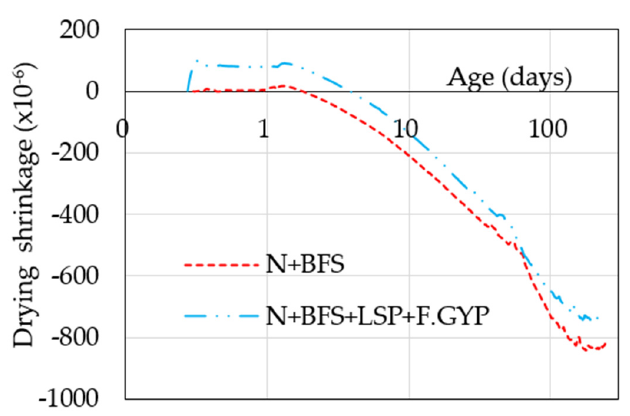
Figure 8. Drying Figure 8. Drying shrinkage. Figure 8. Drying shrinkage.